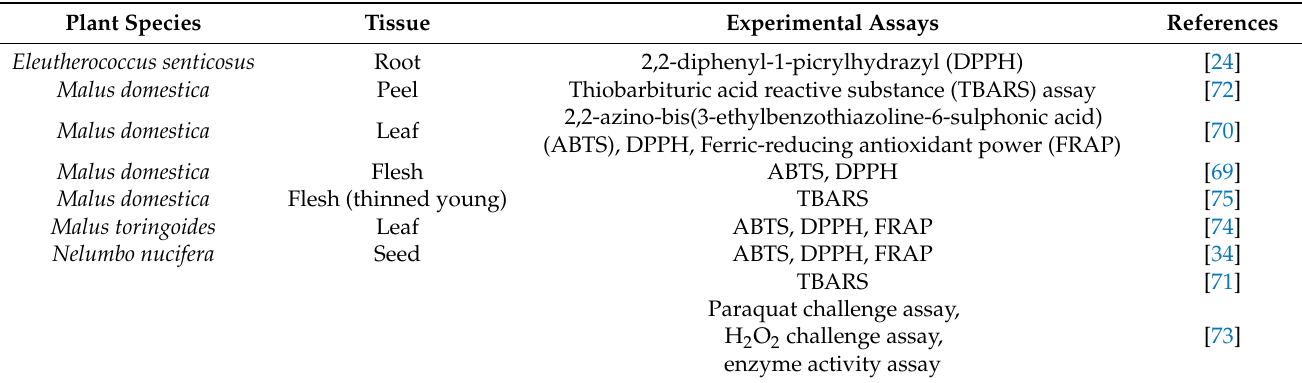
Table 2. Antioxidant effects of